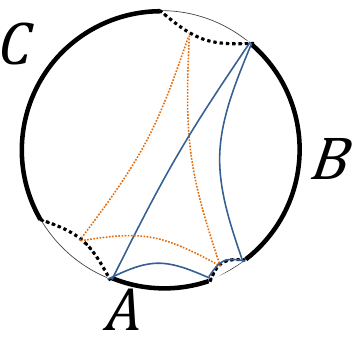
Figure 4 . The proof of an upper bound of (cid:1) W . The sum of blue real lines is S A + S B + S AB and the sum of dashed yellow lines are (cid:1) W ( (cid:26) ABC ). Clearly (cid:1) W ( (cid:26) ABC ) (cid:20) S A + S B + S AB holds somewhat trivially since S A + S B + S AB has UV divergences while (cid:1) W does not. When two of subsystems share the boundary, (cid:1) W also diverges, but it is always weaker than S A + S B + S AB shown by a